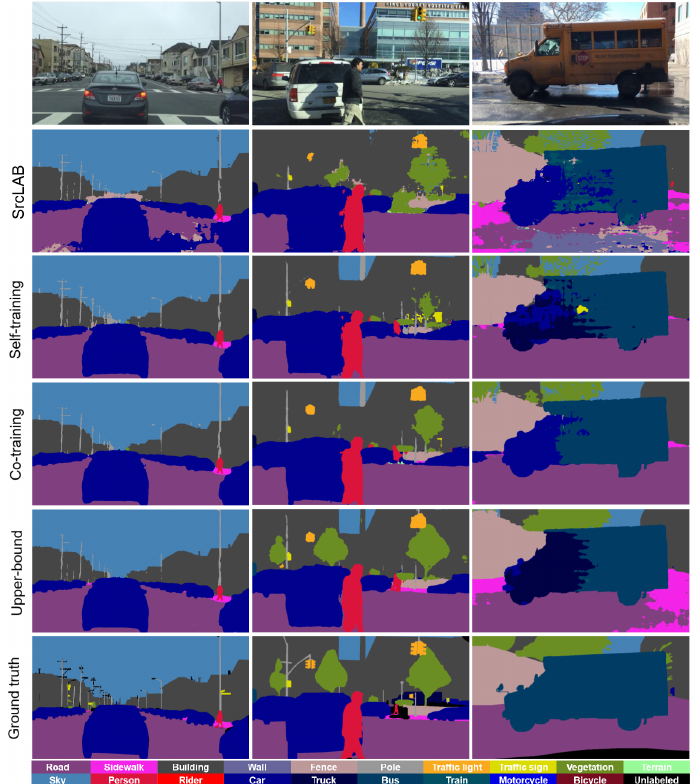
Figure A6. Qualitative results similar to Figure A4 when using BDD100K as target.